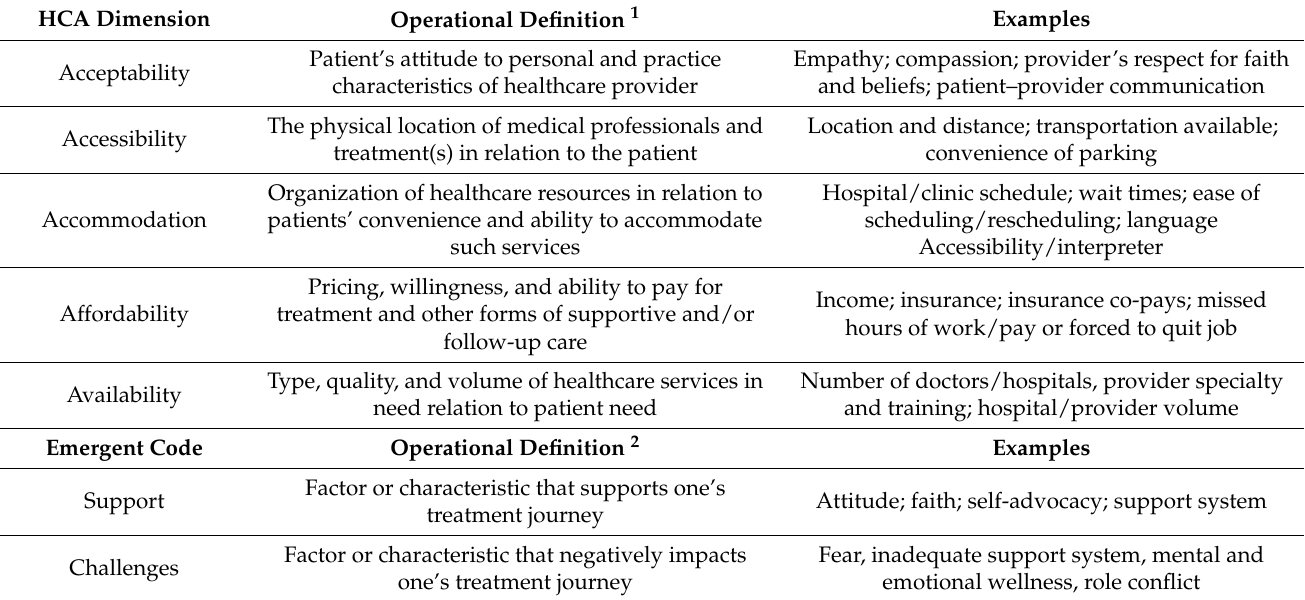
Table 1. Operational Definitions for Healthcare Access Dimensions and Emergent